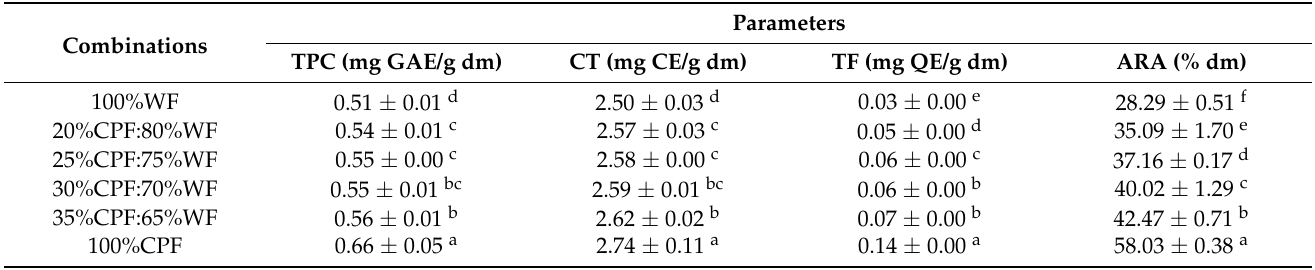
Table 2. Total phenolic compounds, condensed tannins, total flavonoids, and antiradical-activity of durum wheat flour, fortified durum wheat flour, and chickpea